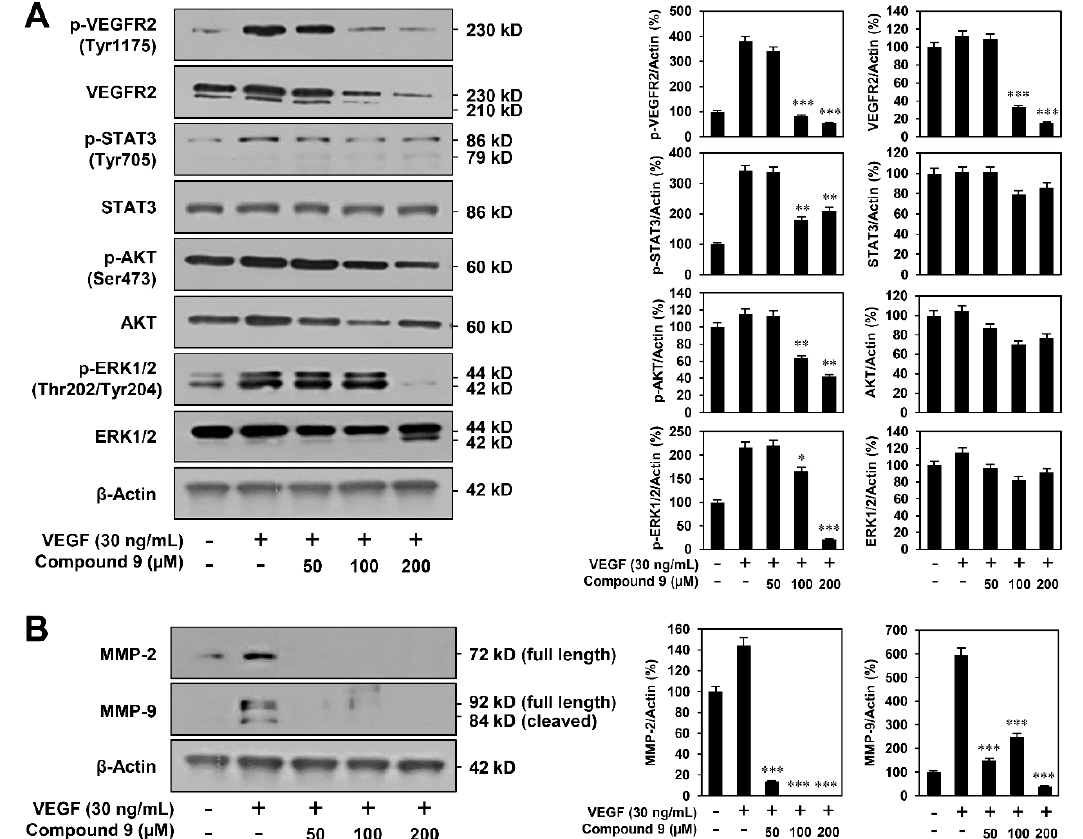
Figure 4. The downregulation of VEGF/VEGFR2-mediated signaling by compound 9. ( A ) VEGFR2 downstream signaling inhibitory activities of compound 9. Serum-starved HUVECs were pretreated with compound 9 (50–200 µM) for 1 h and then stimulated with VEGF (30 ng/mL) for 10 min. ( B ) MMP-2 and MMP-9 inhibitory activities of compound 9. Serum-starved HUVECs were treated with compound 9 (50–200 µM) in the presence of VEGF (30 ng/mL) for 24 h. ( A,B ) Protein levels were detected by Western blot analysis and further quantified by densitometry. The level of β -actin was used as an internal control. * p < 0.05, ** p < 0.01, *** p < 0.001 vs. the VEGF control. Each value represents the mean ± SD from three independent experiments.